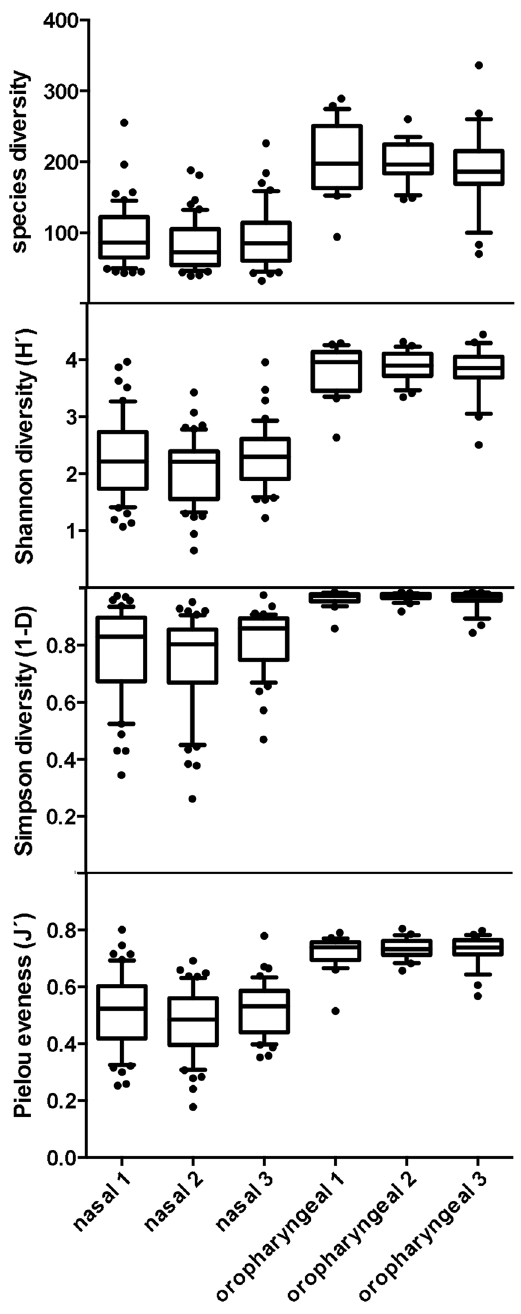
Figure 5. Community diversity in anterior nares and oropharynx according to swab type. The species richness, Shannon diversity index (H ′ ), Simpsons diversity index (1-D), and Pielou’s evenness index of communities collected by three different swabs (swab 1, flocked nylon swab; swab 2, rayon swab; swab 3, polyurethane tipped swab) are shown. The whiskers of the plots indicate 10–90 percentiles. The number of swabs analyzed were 54 (swab 1), 52 (swab 2) and 44 (swab 3) nasal swabs and 39 (swab 1), 34 (swab 2) and 37 (swab 3) oropharyngeal swabs. There was no statistically significant difference in the diversity observed in communities obtained with the different swabs, whereas communities taken from the nares or the oropharynx were significantly different (p <